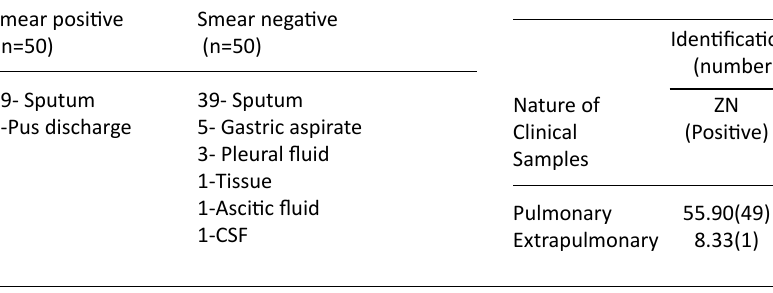
Table 3. Sensitivity of different tests in pulmonary